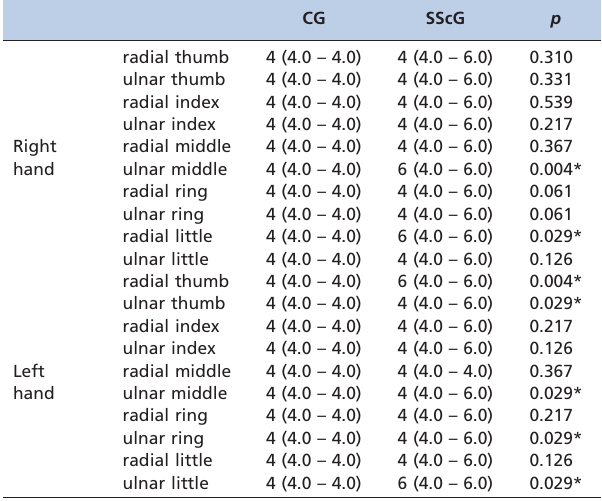
Table 5 - Comparison of points tested on right and left hands in the two-point discrimination test for the control